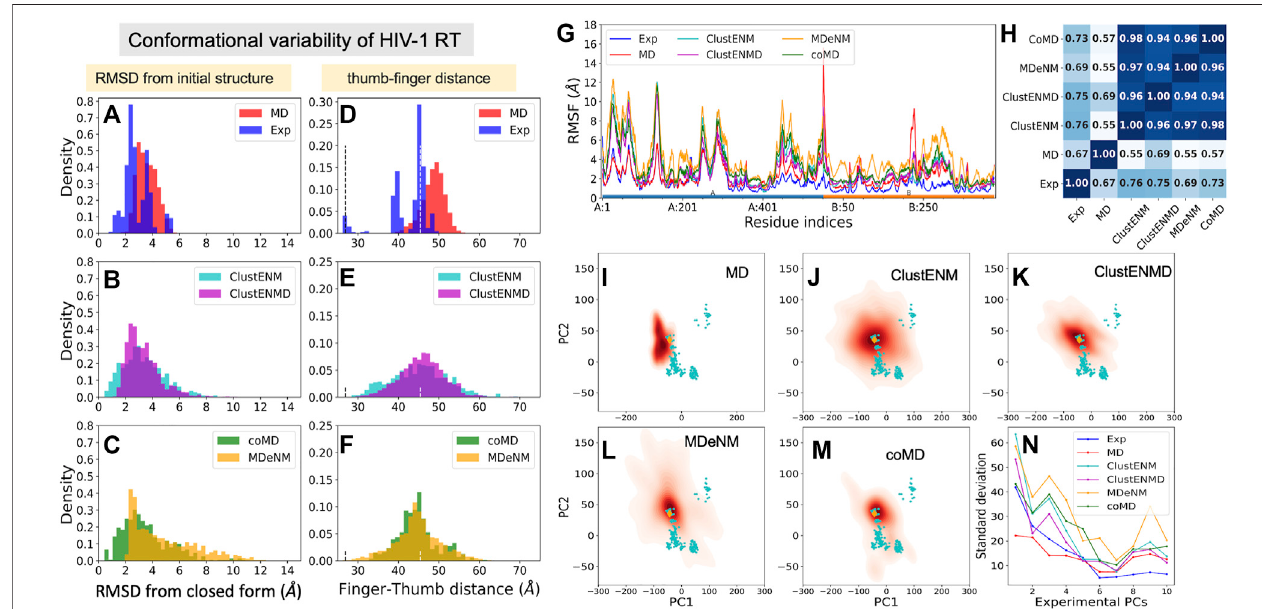
FIGURE8| ComparisonofcomputationalandexperimentalensemblesofHIV-1RT. (A – C) RMSDswithrespecttothestartingclosedligand-freestructure(PDBid: 3kli). (D – F) Distances between the centers of mass of the fi ngers (residues 1 – 85 to 112 – 155) and thumb (residues 242 – 312) subdomains on the p66 subunit (chain A) thatdescribeopen-to-closed fl uctuationsofthetwosubdomains. Dashedlines indicatethedistancesintheopenandclosedreferencestructures(PDBid:2b6aand3kli, respectively). (G) RMSFs for each ensemble. The bars underneath indicate the p66 subunit (chain A; blue ) and the p51 subunit (chain B; orange ). (H) Pearson correlation coef fi cients between pairs of RMSF pro fi les. (I – M) Population distributions for ensembles generated by (I) MD, (J) ClustENM, (K) ClustENMD, (L) MDeNM, and (M) coMD. (N) Standard deviations of the conformers projected along the experimental